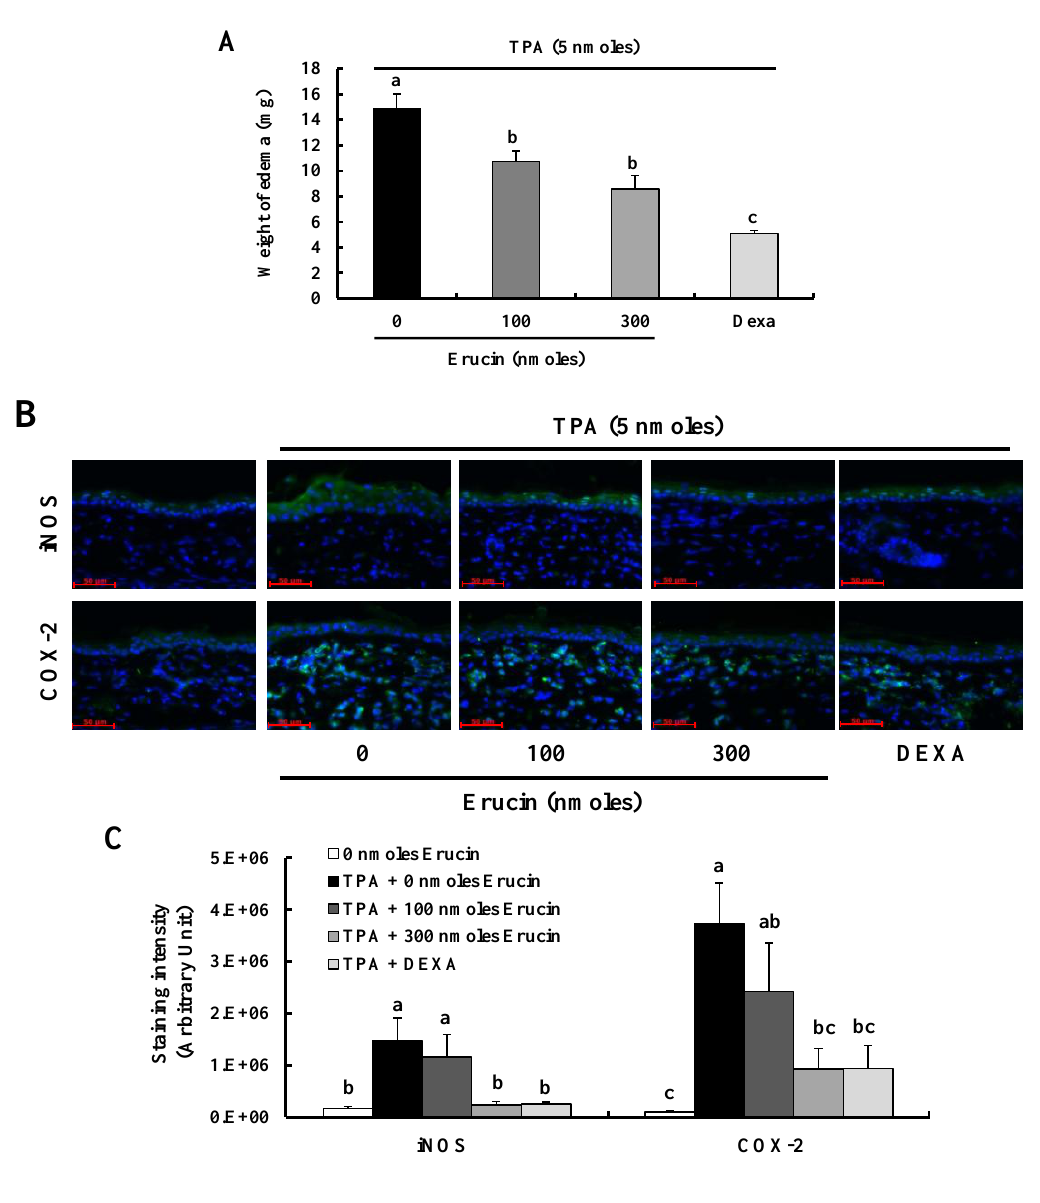
Figure 5. Erucin decreases 12- O -tetradecanoylphorbol-13-acetate (TPA)-induced edema formation in a mouse inflammation model. Erucin was topically applied to the mouse